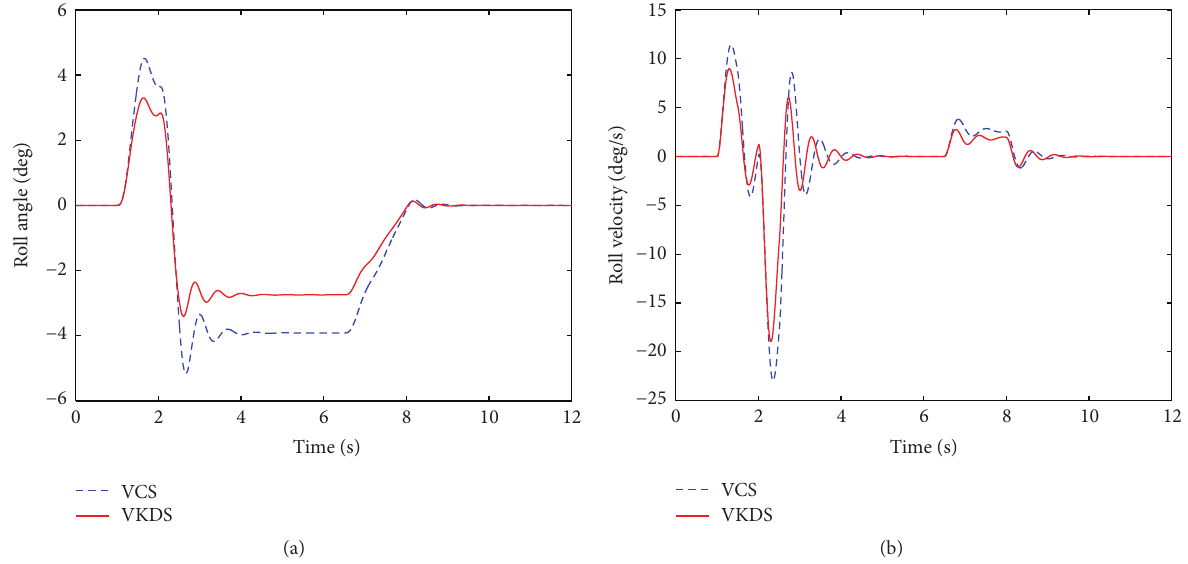
Figure 7: (a) Sprung mass roll angle of the VCS and VKDS under the fishhook maneuver. (b) Sprung mass roll